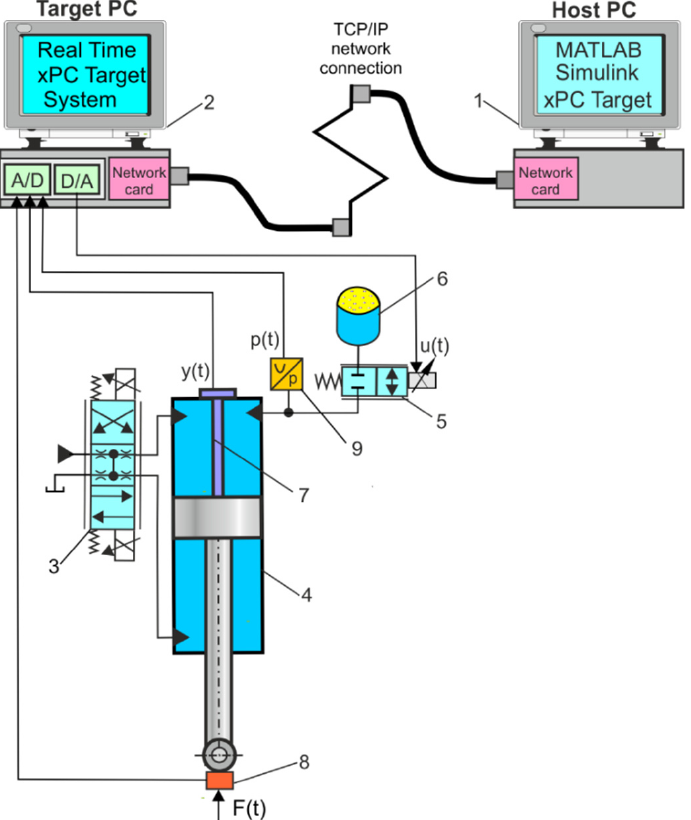
Figure 21. Schematic diagram of distributed measurement and control system: 1: Host PC, 2: Target PC, 3: proportional directional control valve, 4: hydraulic lift actuator, 5: proportional damping valve, 6: hydropneumatic accumulator, 7: linear position transducer, 8: force transducer, 9: pressure transducer.